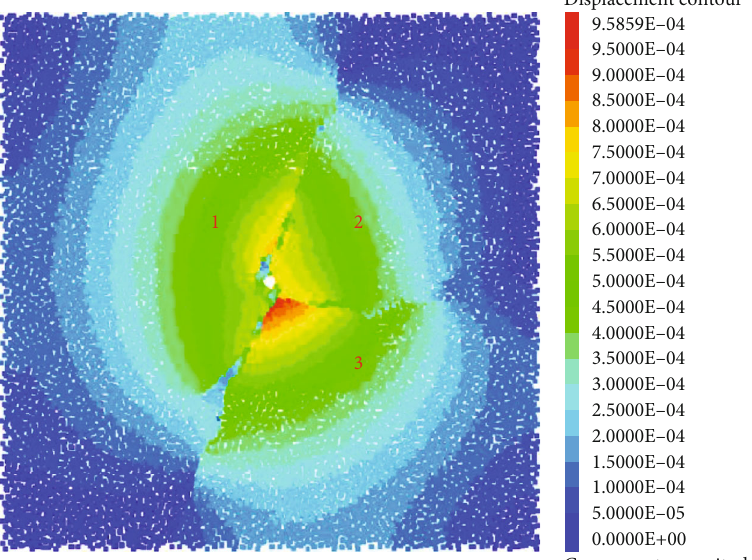
Figure 20: Discontinuous displacement fi eld for θ = 45 °